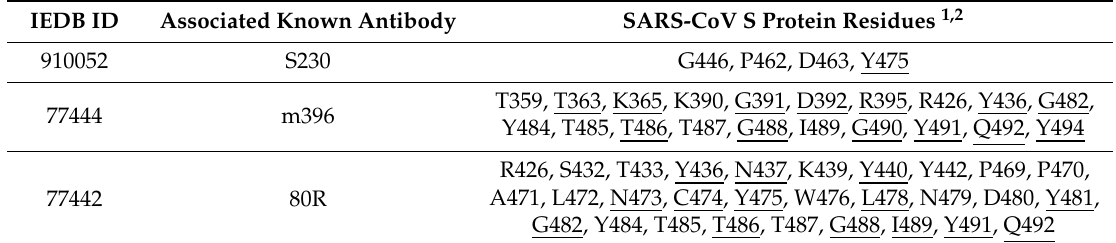
Table 5. SARS-CoV-derived discontinuous B cell epitopes (and associated known antibodies [39–41]) that have at least one site with an identical amino acid to the corresponding site in SARS-CoV-2. IEDB